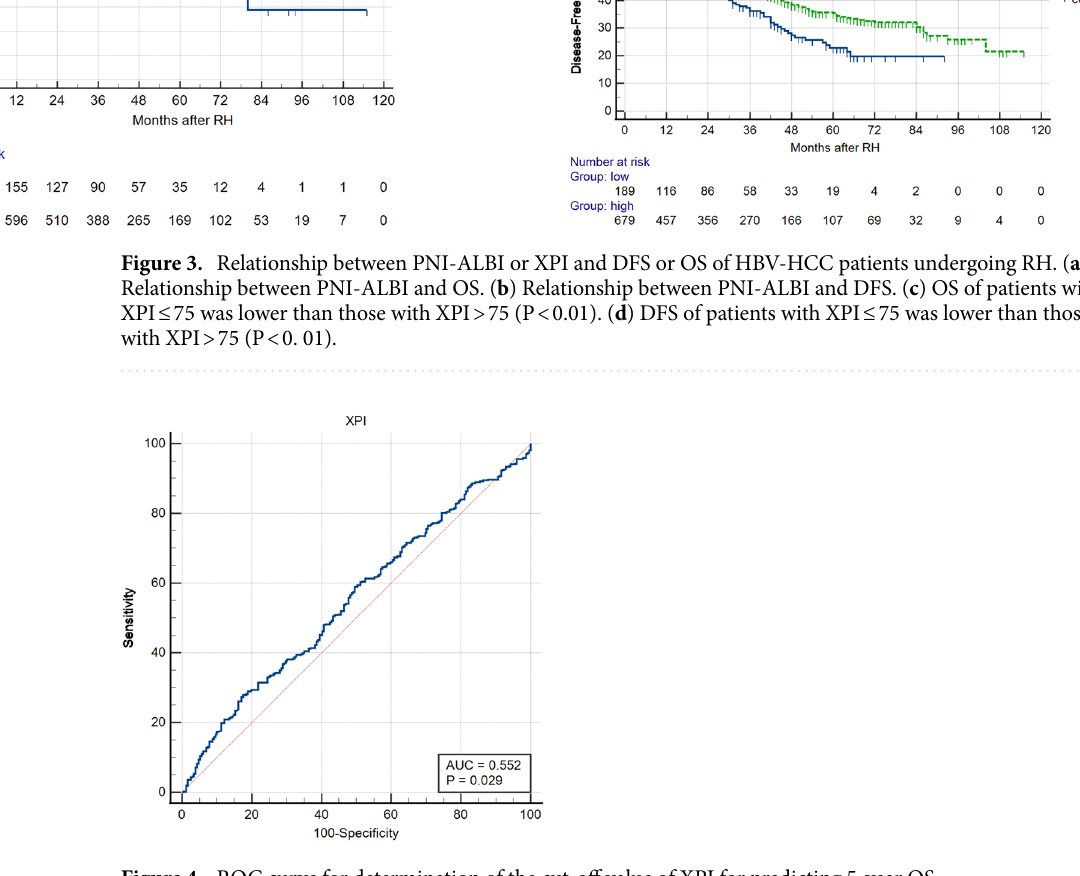
Figure 4. ROC curve for determination of the cut-off value of XPI for predicting 5-year